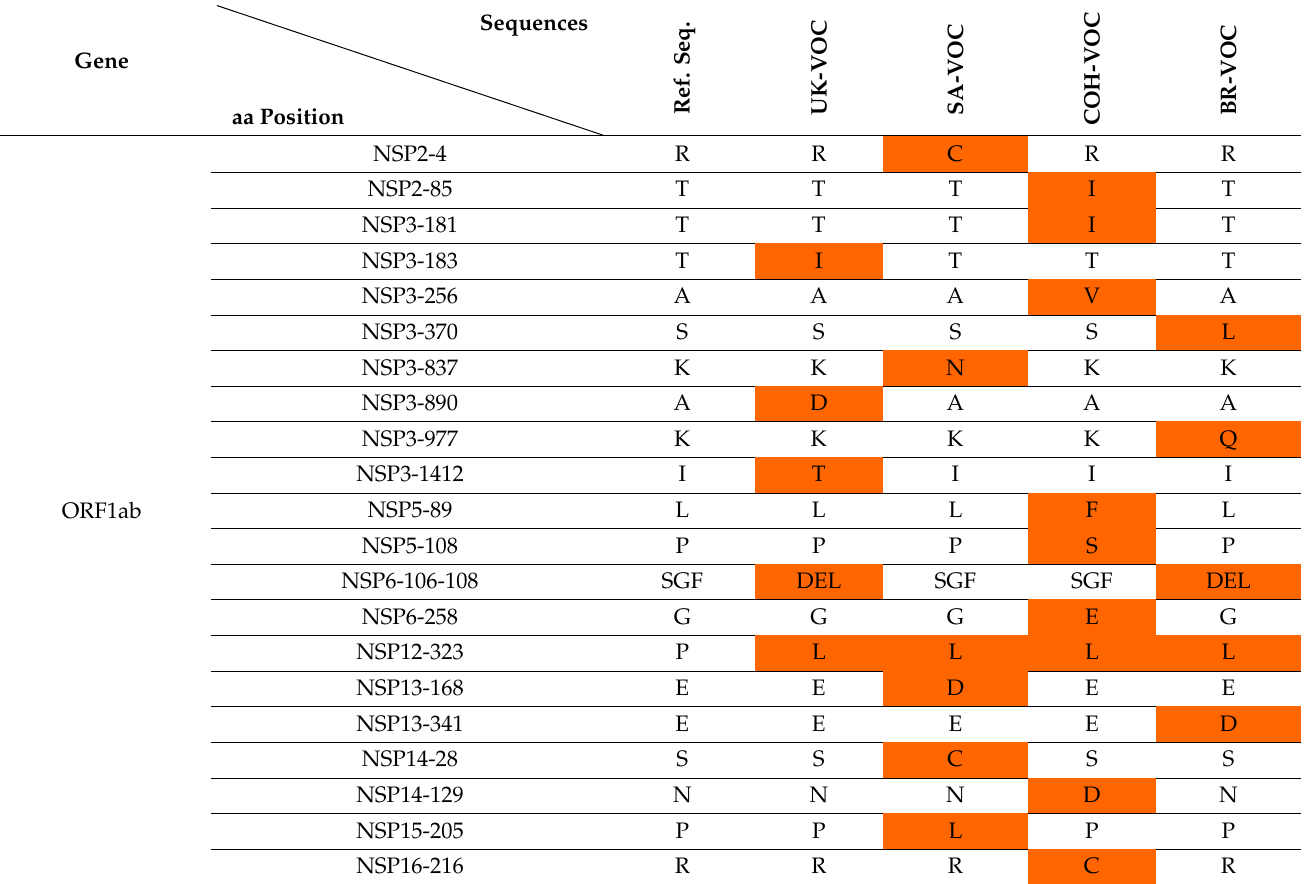
Table 1. Nonsynonymous mutations of four recent VOC (UK-VOC, SA-VOC, COH-VOC, B.J-VOC) are compared with SARS-CoV-2 reference sequence as WT variant. RBD and O-linked glycan domain (OGD) are colored as blue and yellow respectively. Mutations are colored as red.